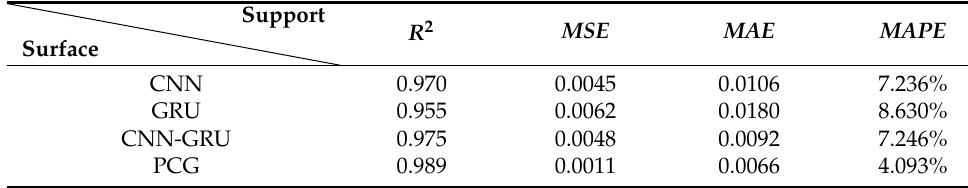
Table 8. Damage degree identification results of the four models.